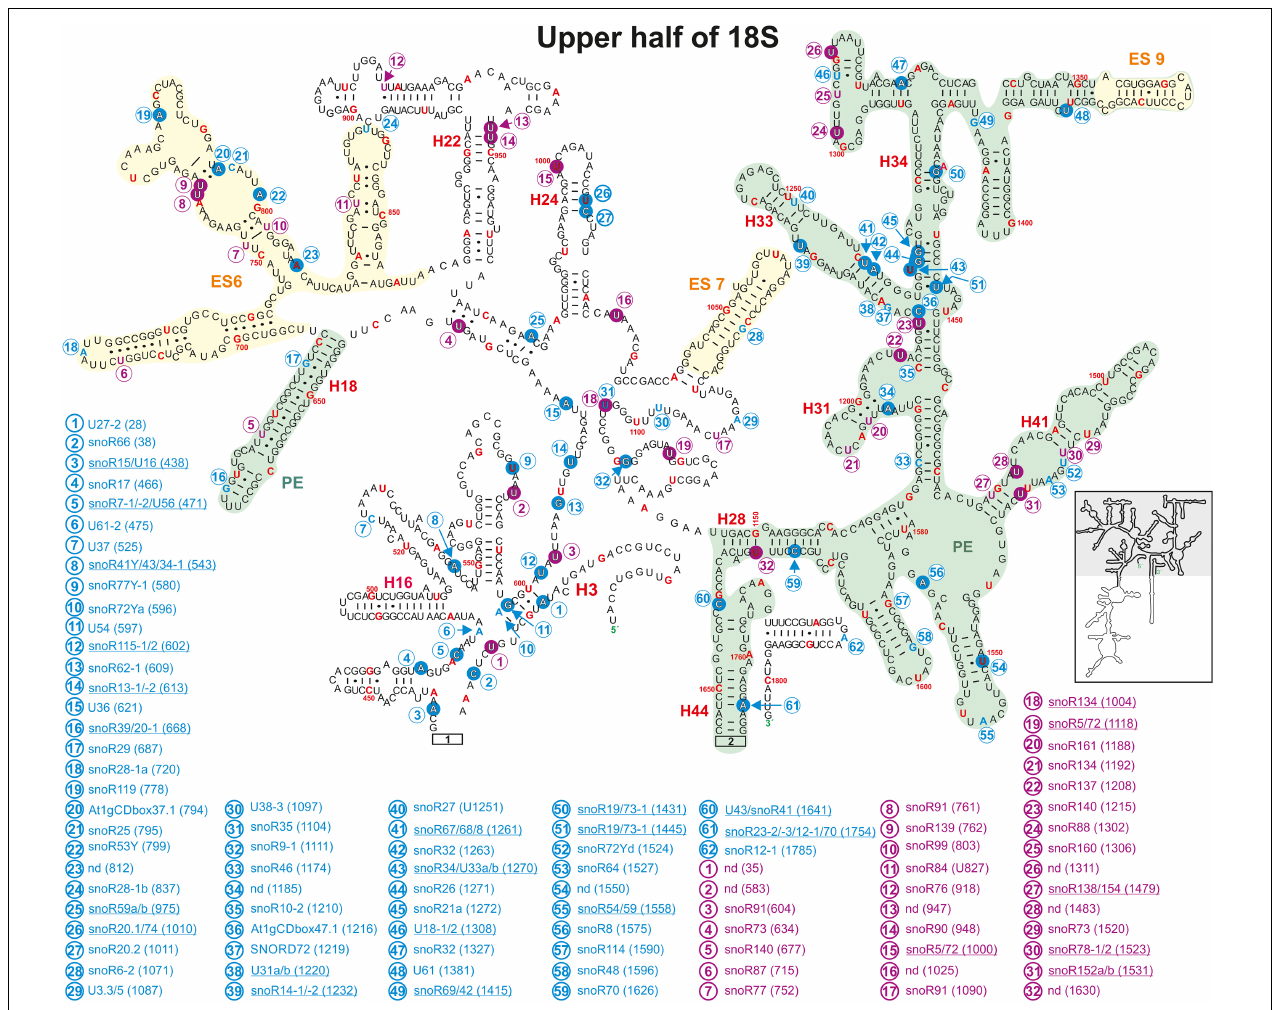
FIGURE 8 | Secondary structure diagram of the 18S rRNA (At2g01010) of A thaliana according to The RNAcentral Consortium (2019). Depicted are the positions from 1 to 41, 436 to 1655, and 1750 to 1804. Predicted and verified positions for 2 (cid:48) -O-ribose-methylations and pseudouridylations, as well as of snoRNAs were obtained from Brown et al. (2001, 2003), Qu et al. (2001), Yoshihama et al. (2013), Sun et al. (2019), Streit et al. (2020). The coloring is according to Figure 3 . Framed large numbers indicate the position of the connections in Figure 9 . PE annotates a pivoting element and ES expansion elements previously identified (Paci and Fox, 2015). The number in brackets correspond to the modified nucleotide position. A small illustration of the whole 40S rRNA secondary structure highlighting the according region is